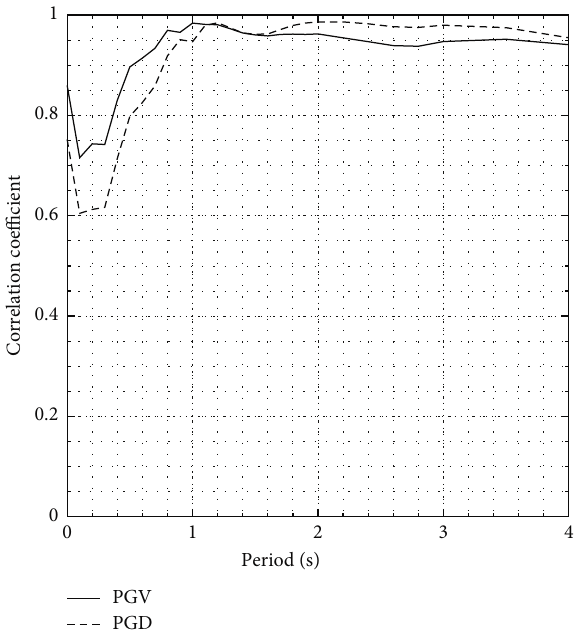
Figure 5: Correlation between the peak ground velocity and peak ground displacement and the spectral